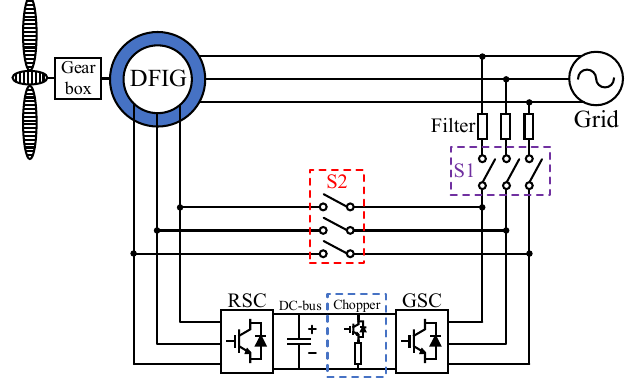
Figure 4. The topology of DFIG-based WECS.